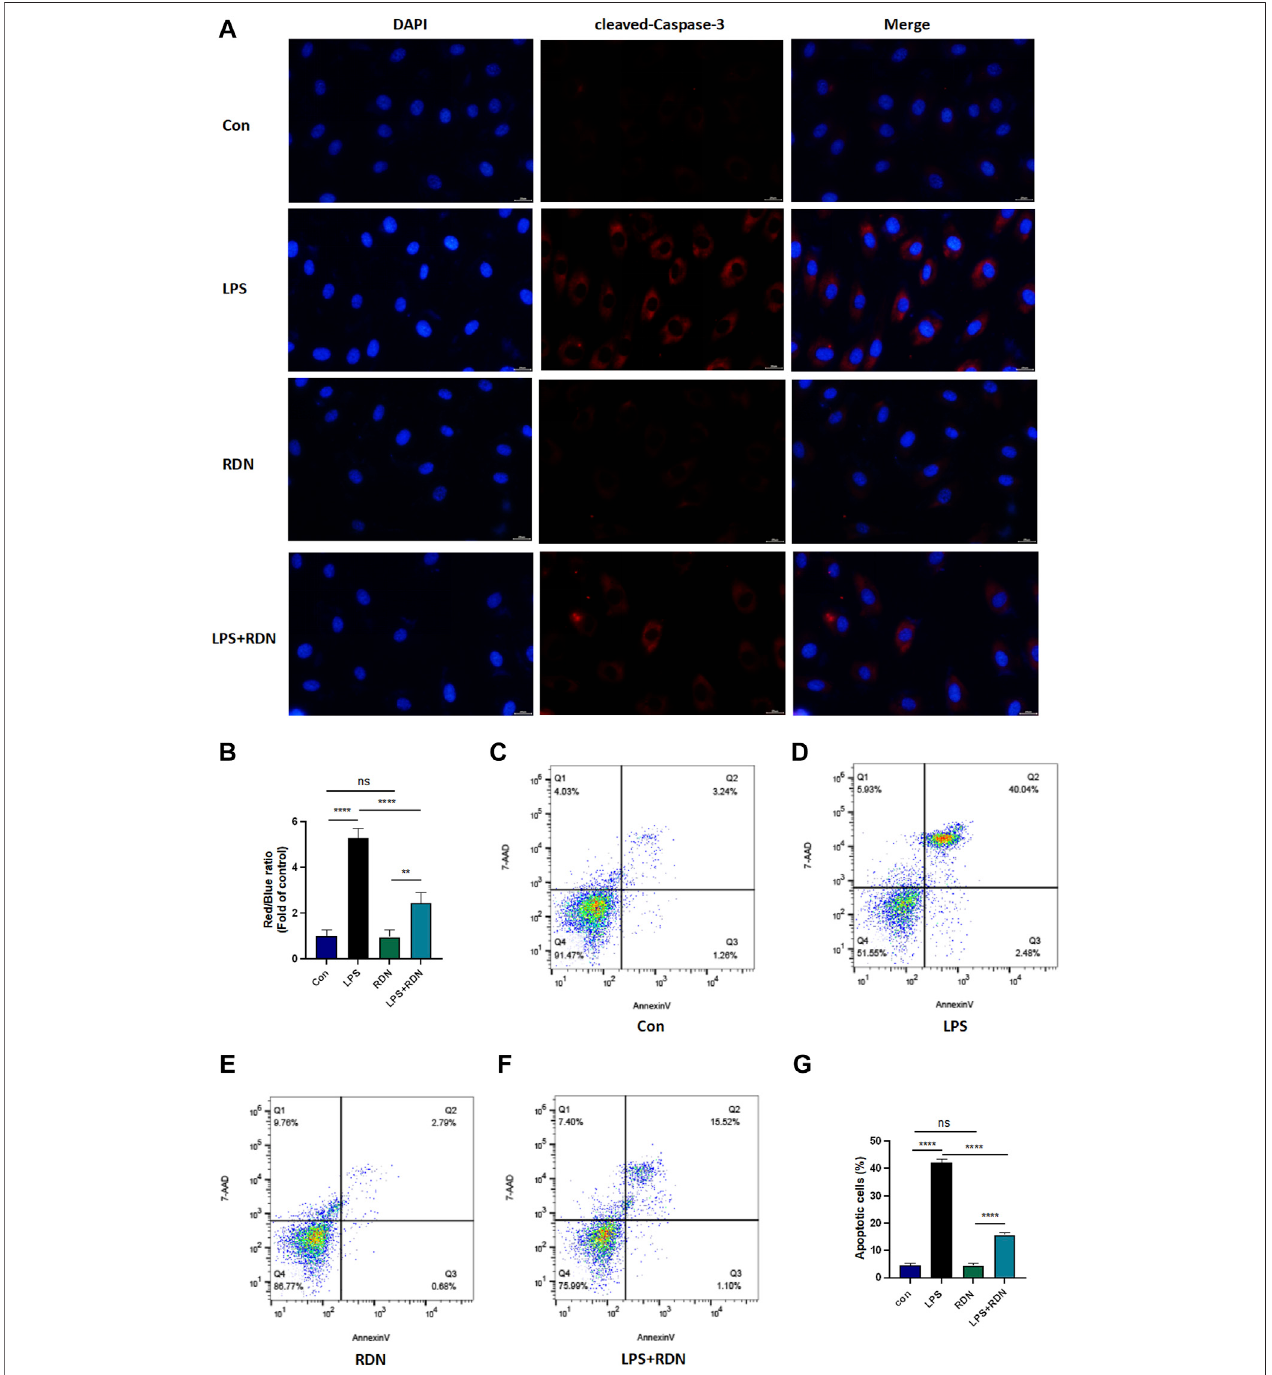
FIGURE 7 | RDN could alleviate LPS-induced HUVECs apoptosis. (A,B) Immuno fl uorescence was performed to detect the level of apoptosis related protein. Magni fi cation×40, scale bar 20 μ m. (C-G) Flow cytometry was employed to detect apoptosis rate. Cells were equally divided into the Con group, LPS group, RDN group,LPS+RDNgroupandevaluatedtheproportionofapoptoticcells(Q2+Q3)ineachgroup.Dataarepresentedasmean±SD( n =3pergroup)oftherepresentative data from three independent experiments; ** p < 0.01, **** p < 0.001.